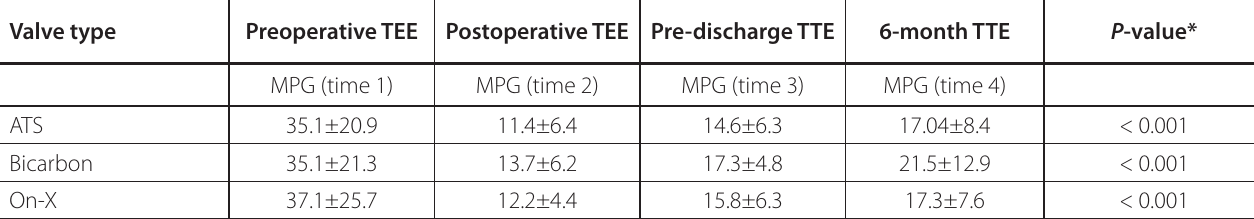
Table 4 . Aortic mean pressure gradient (mmHg) at four-time